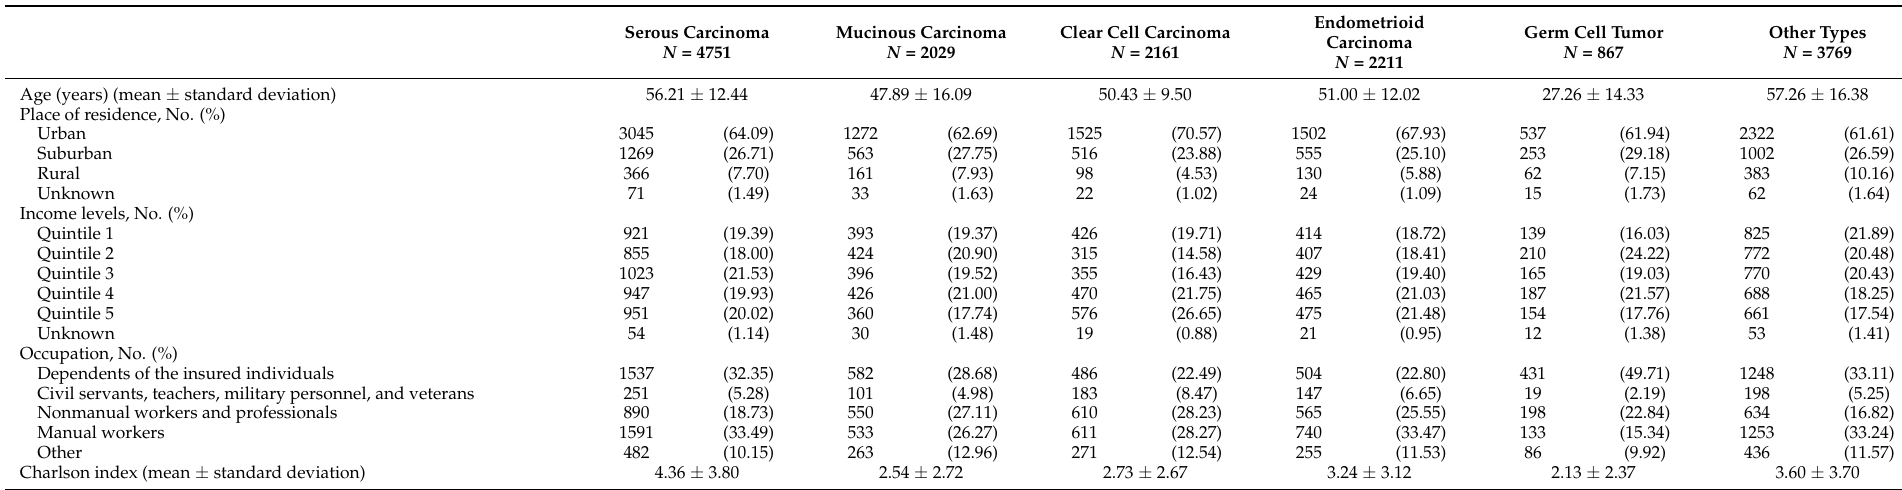
Table 6. Clinical characteristics of ovarian cancer patients with different histological subtypes in Taiwan from 2002 to 2015. Serous Carcinoma N =